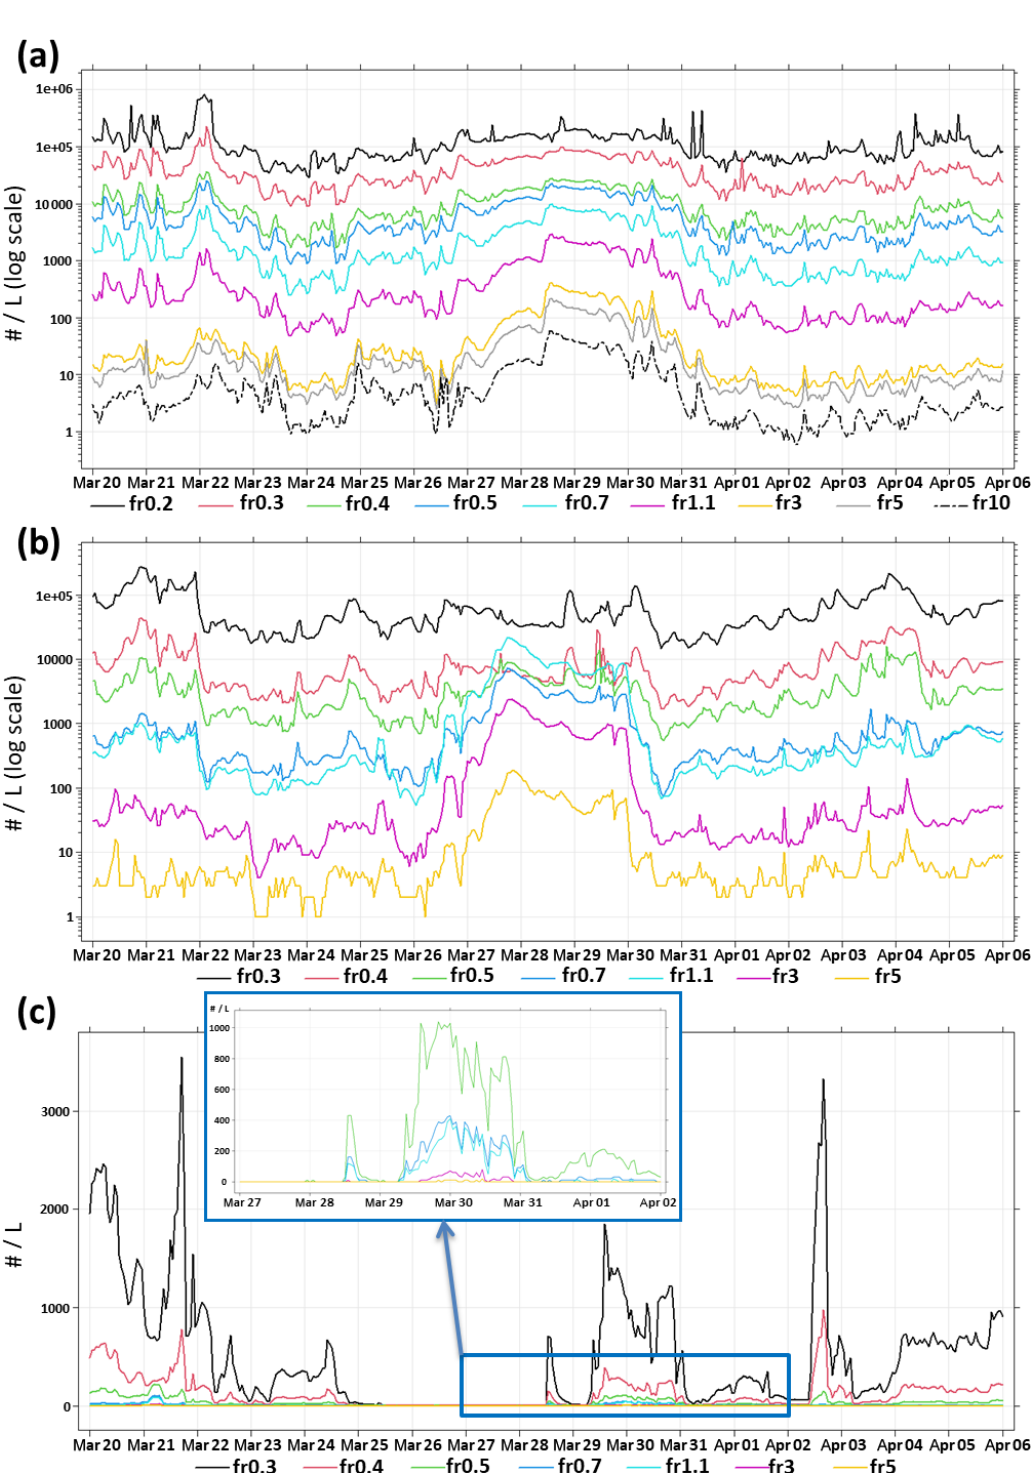
Figure A4. Temporal trends in all fractions for the three OPCs: (a) LOAC (Bologna), (b) FAI (Trieste), and (c) Mt. Cimone (the blue rectangle shows a zoomed in view of the coarser fractions). For BO and TS, values are reported on a logarithmic scale. Values are in counts per cubic decimeter (no.L − 1